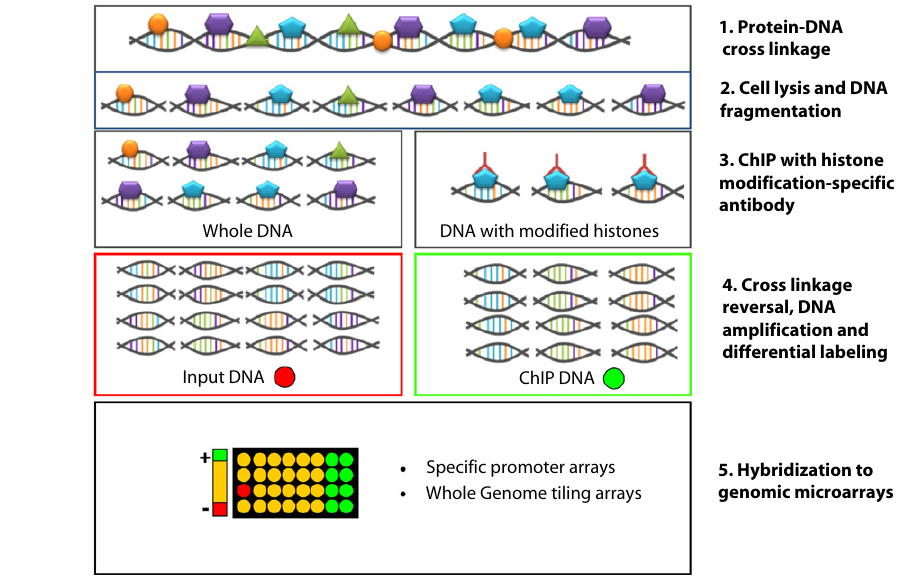
Figure 6. Graphic representation of the ChIP-on-chip method. ChIP-on-chip combines Chromatin Immunopre- cipitation with microarray technologies. In the initial step of this method proteins are cross-linked on the